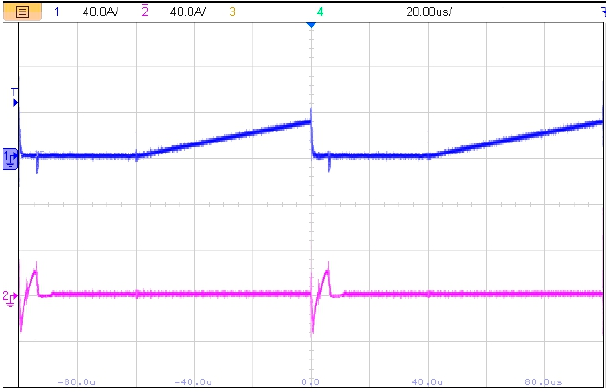
Figure 13. Main switch current (blue–Scale: 40 A/div) and snubber current (purple–Scale: 40 A/div).